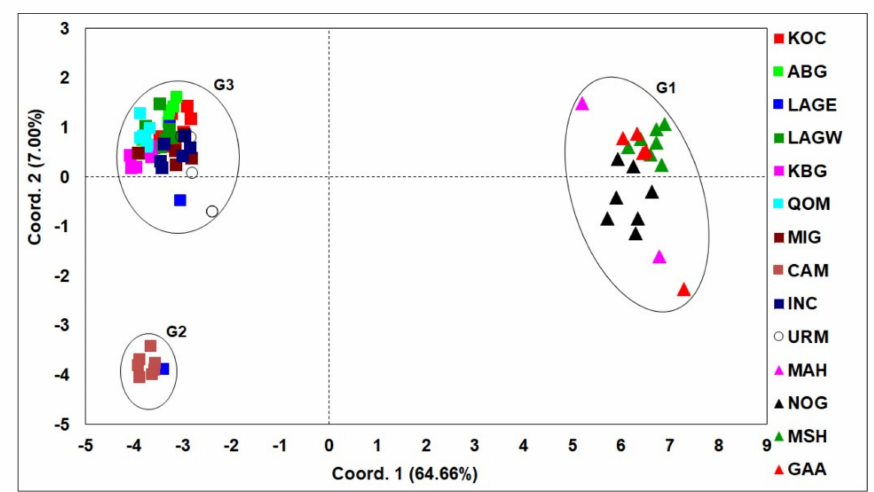
Figure 8. Principal Coordinates Analysis (PCoA) showing di ff erentiation patterns among whole examined populations based on ISSR markers (abbreviations listed in Table